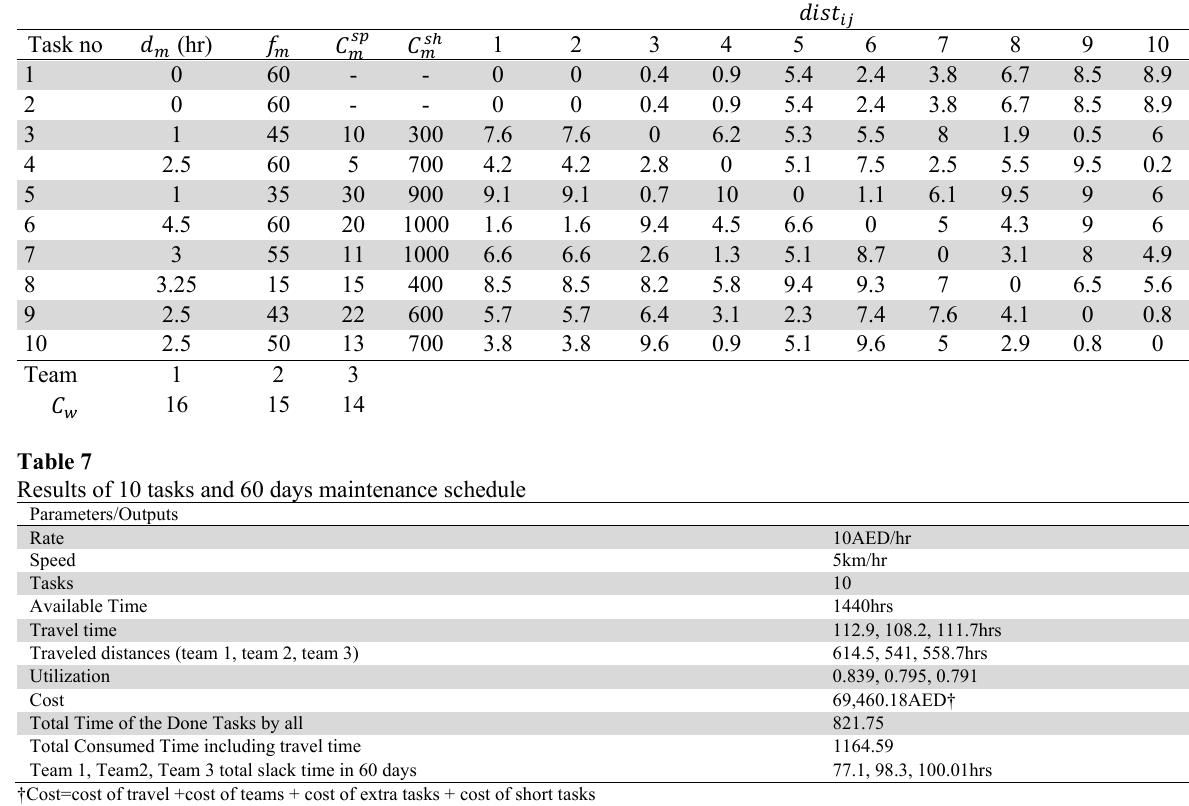
Data for the fourth scenario. All costs in AED.